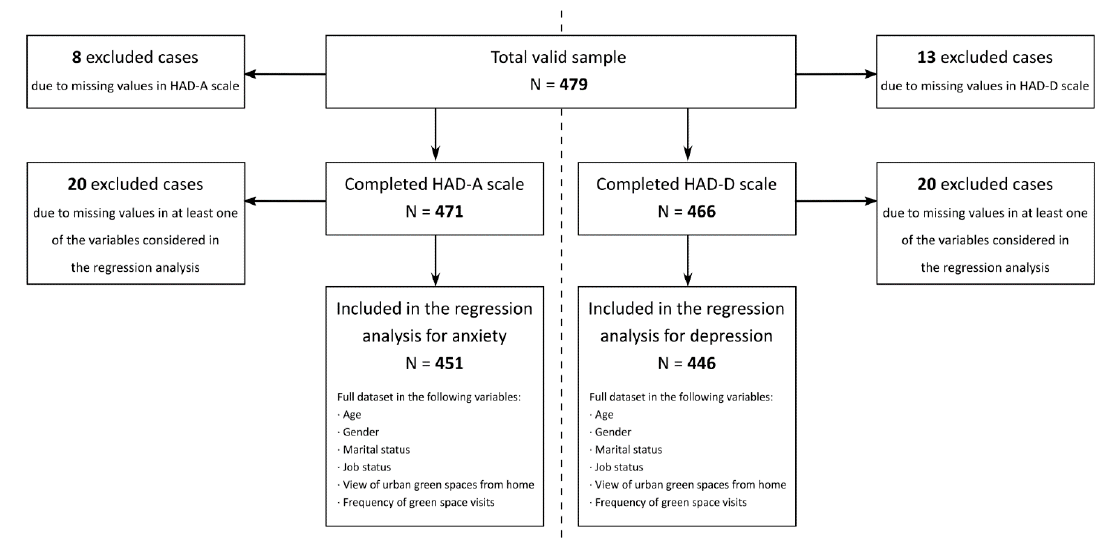
Figure 2. Study sample selection flow chart.